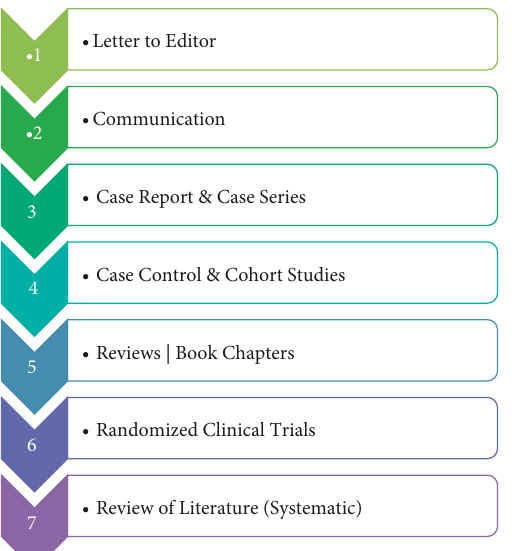
Figure 1: Types of manuscripts based on complexity of content and